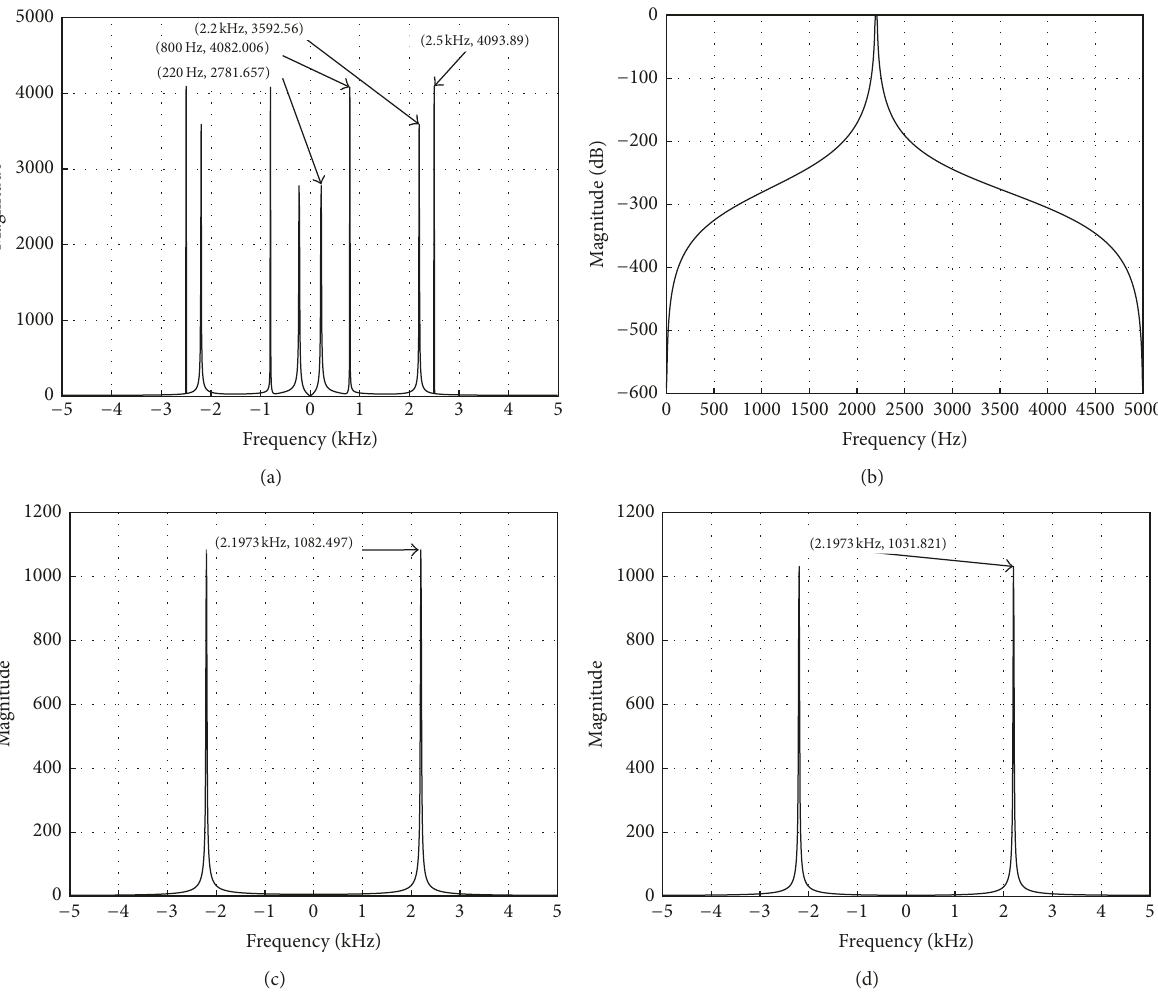
Figure 15: The results of IIR filter testbench. (a) Magnitude spectrum of input signal. (b) IIR filter frequency response (filter response parameters: sampling frequency = 10kHz , lower cutoff frequency = 2.190 kHz , higher cutoff frequency = 22.10 kHz , passband ripple = 0.1dB , stopband attenuation = 200 dB , number of coefficients = 6 , and number of sections = 6 ). (c) Magnitude spectrum of Matlab IIR filter output. (d) Magnitude spectrum of FPGA IIR filter